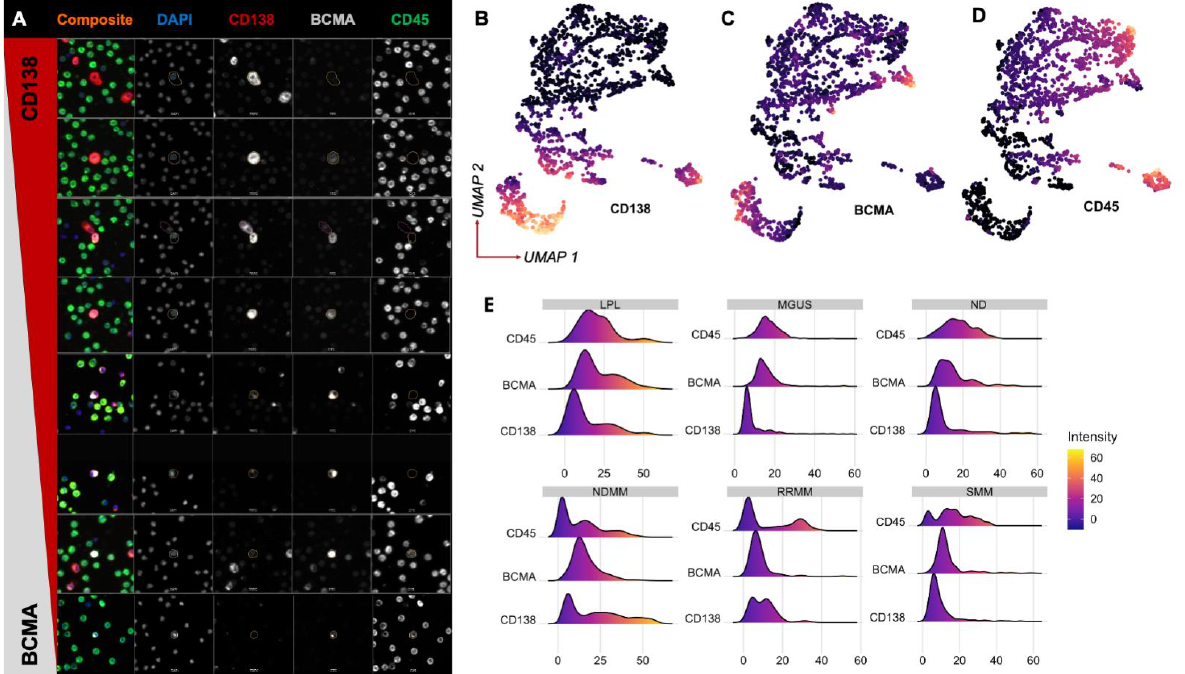
Figure 2. Morphological characterization of BCMA+ cells in PB samples: ( A ) Representative candidate rare cells with comparative BCMA and CD138 expression across different cell sizes. ( B ) UMAP projection of all candidate cells using all 761 single-cell morphology and marker intensity features, colored by CD138 expression. ( C ) UMAP projection, colored by BCMA expression. ( D ) UMAP projection, colored by CD45 expression. ( E ) Density plots showing channel intensities for each disease state.